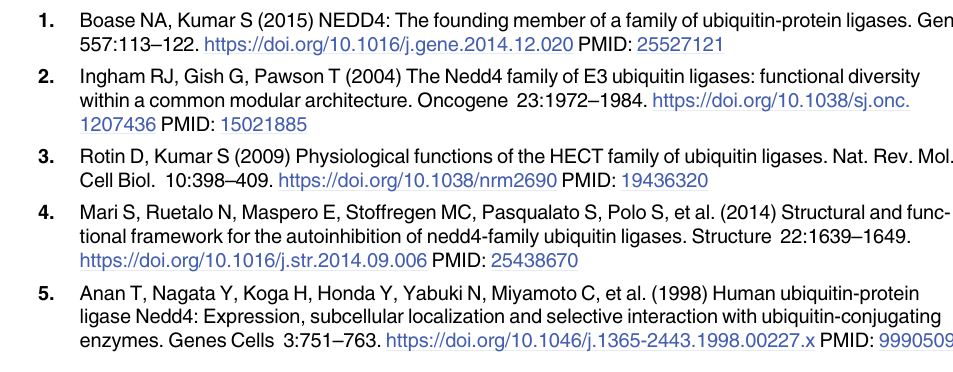
S2 Table. Proteins identified as non-PY containing with PxYFinder but labeled as PY con- taining in test data set (from Persaud et al., 2009)